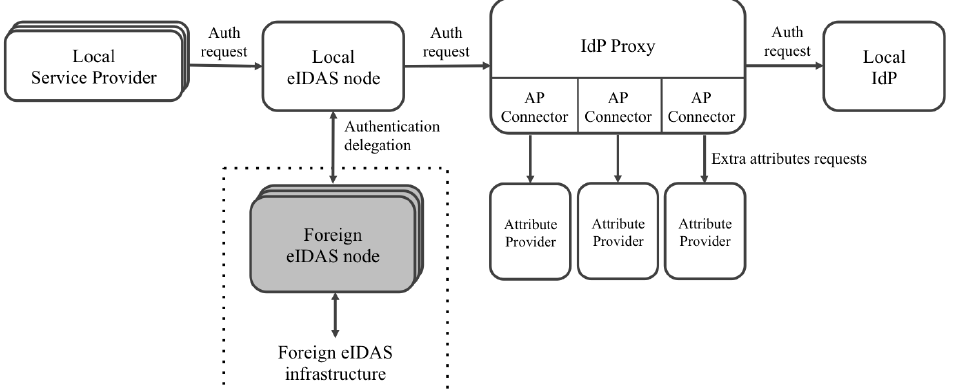
Figure 2. Connection to the attribute providers’ architecture. IdP, Identity Provider.